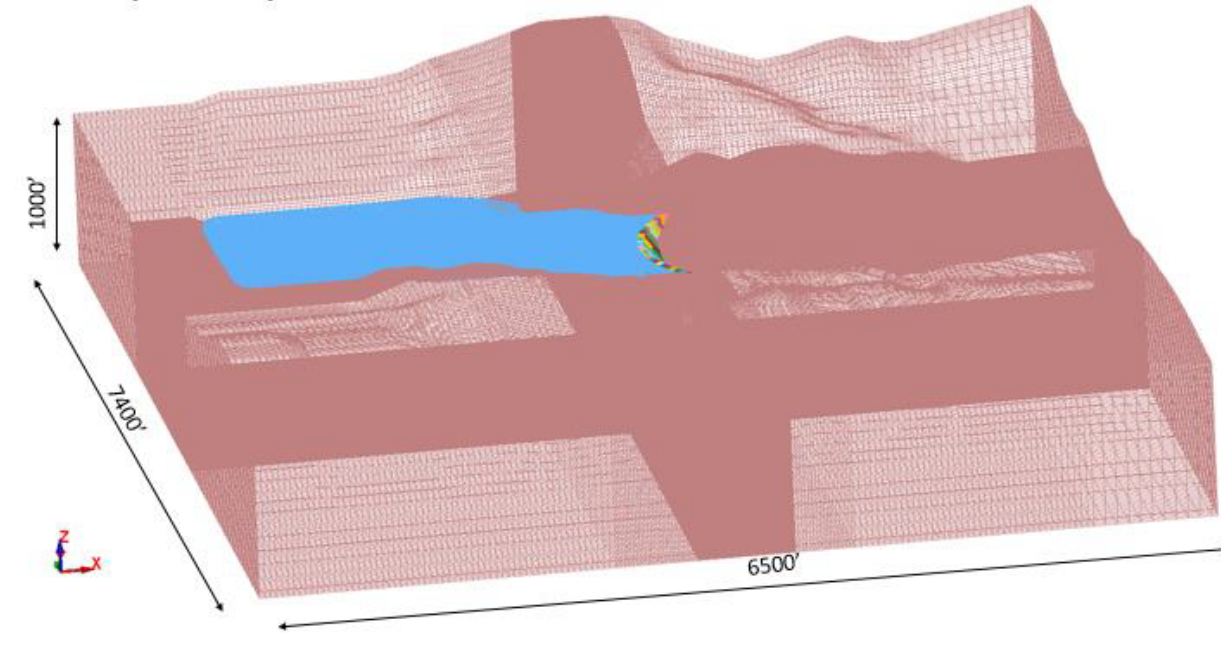
Figure 2. 3D Isometric View of Scoggins RCC Dam LSDYNA Model. Brown color represents abutment and foundation materials, blue shows limits of reservoir included in the model and the curved and colored item in middle of figure is the proposed dam.